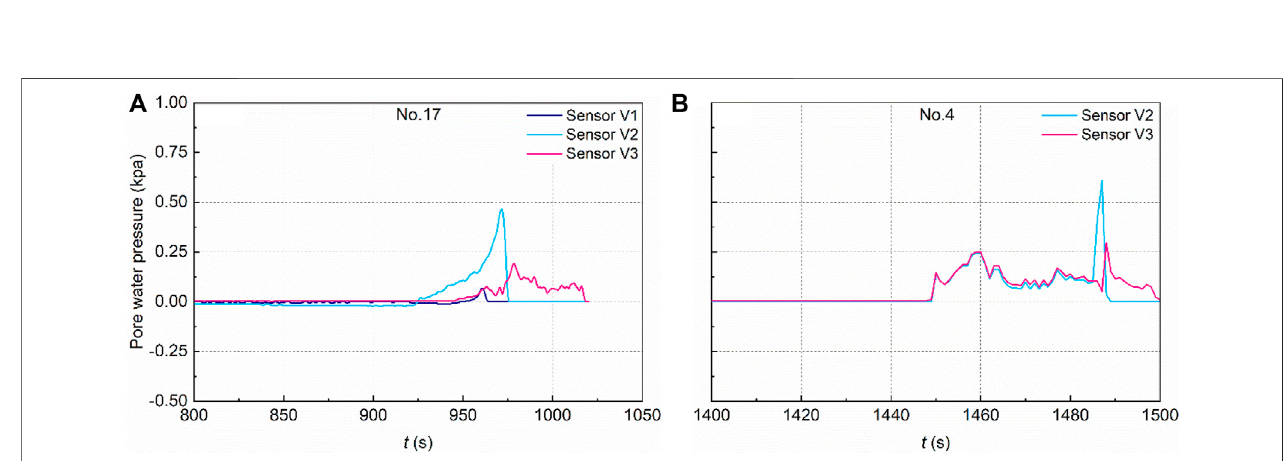
FIGURE 6 | Example plots showing temporal variation in pore pressure measured from the partial (A) and en masse (B) collapsed dam, respectively.